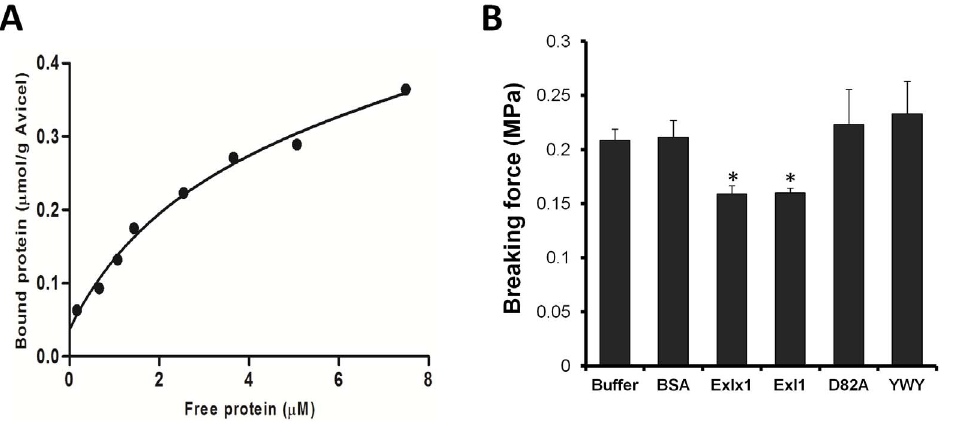
Figure 2. PcExl1 binds and acts on cellulose. (a) Binding isotherm of PcExl1 to Avicel. The result shown is representative of two more determinations. (b) Weakening activity of filter paper by PcExl1. Filter paper strips were incubated for one hour in phosphate buffer pH 7.5 alone or with 120 m g/ml of PcExl1 or BsEXLX1 or bovine serum albumin (BSA) for one hour, and then immediately analyzed in a Universal Testing Machine. Experiments are the result of at least six determinations. *Significant differences ( p , 0.05, Fisher’s LSD